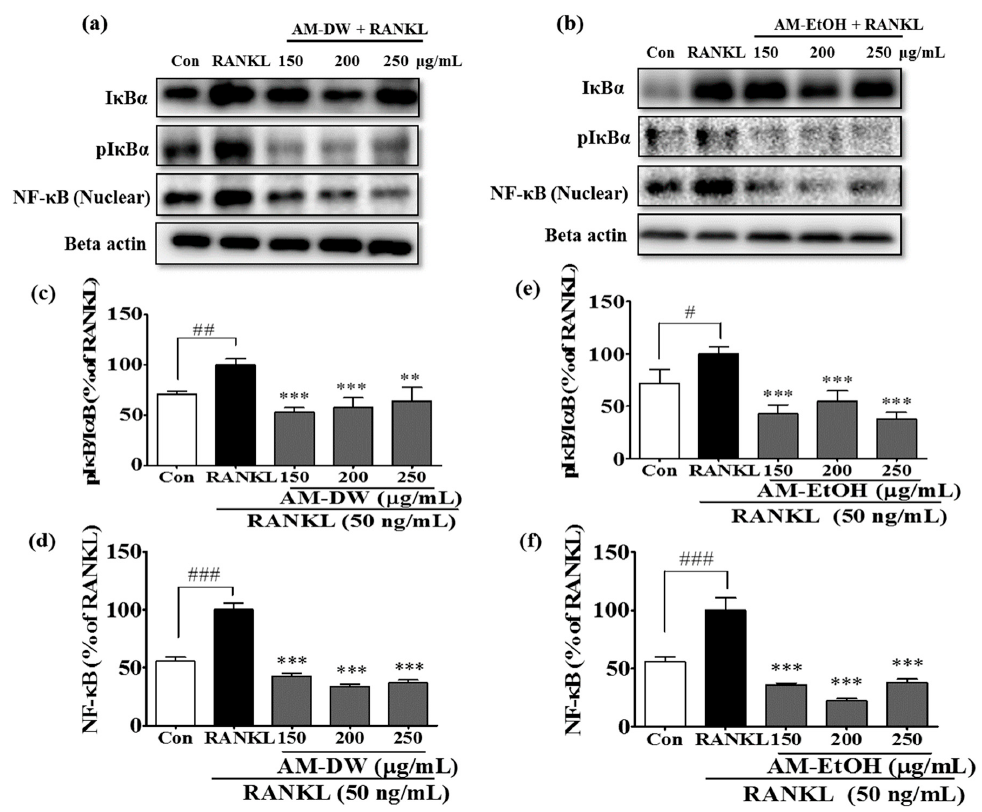
Figure 6. Inhibition of NF- κ B activation of RANKL induced osteoclast in RAW 264.7 cells by AM extracts. ( a,b ) AM extracts altered the phosphorylation of the I κ B α and inhibited nuclear translocation of NF- κ B. ( c – f ) Band intensities of pI κ B α /I κ B α and NF- κ B for AM water and ethanol extracts. Cells were exposed to RANKL (50 ng/mL) in the presence and absence of AM extracts for 3 days. The expression of the proteins were determined by Western blot analysis and Beta actin was used as loading control. RANKL treated group was considered as 100% for densitometric analysis. All